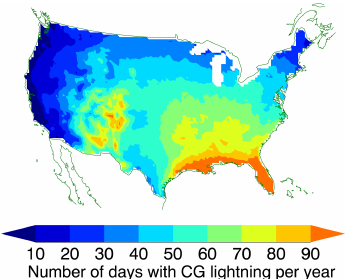
Figure 3. Number of days with NLDN-detected cloud-to-ground (CG) lightning per model grid cell per year during 2005–2014. The lightning occurrences are calculated using the REAM grid resolu- tion.